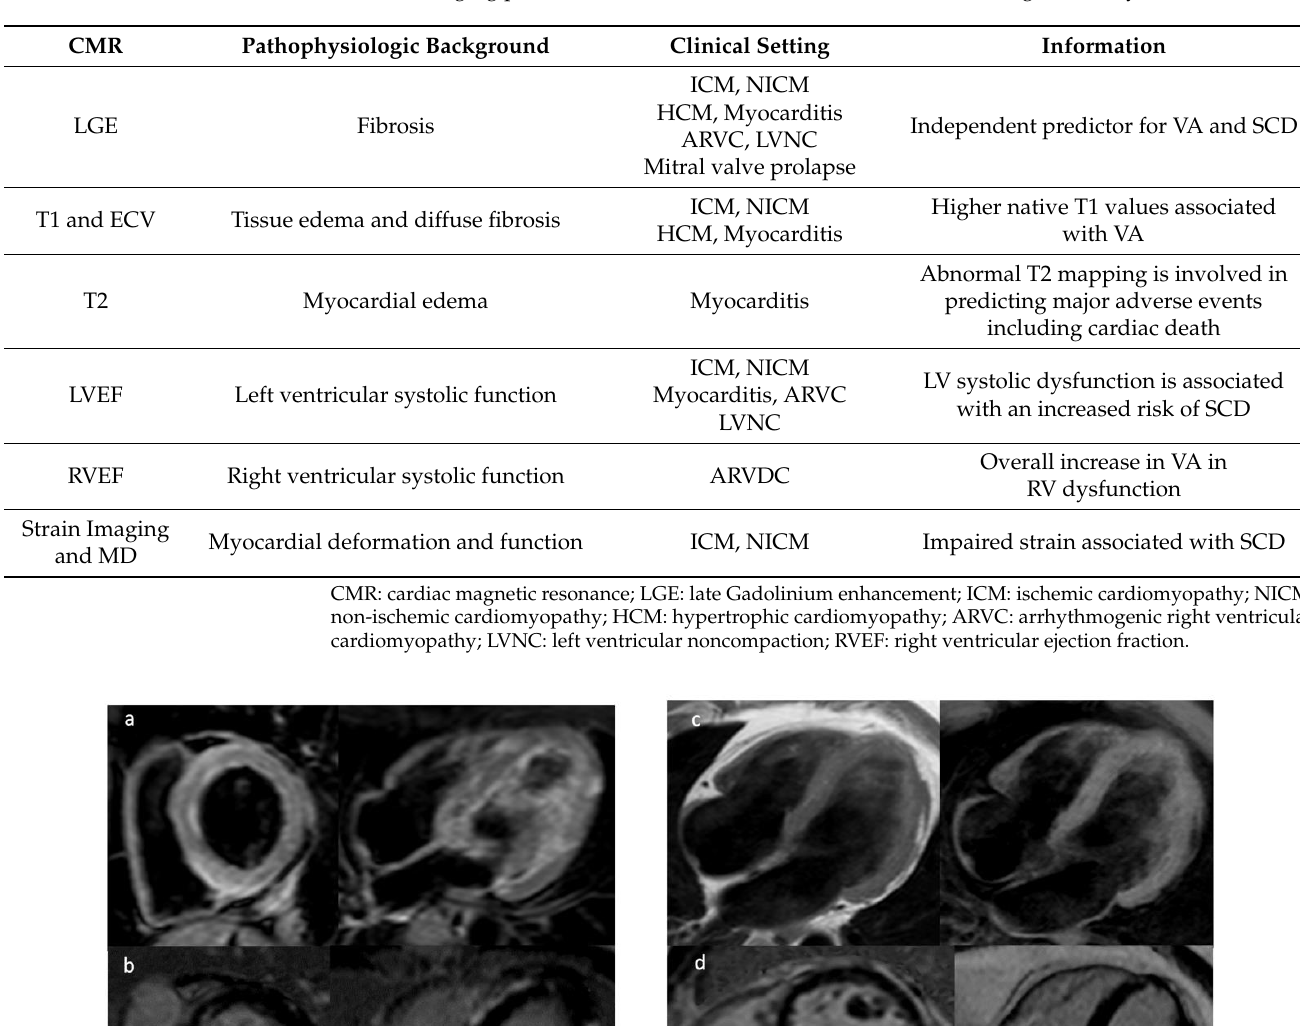
Table 3. Imaging parameters associated with an increased risk of malignant arrhythmias.